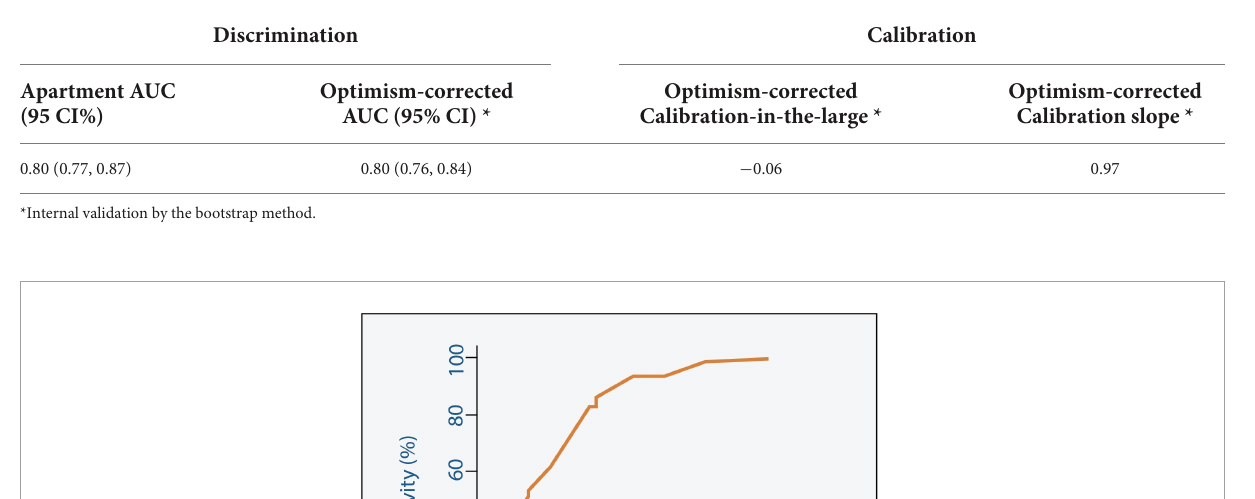
TABLE 6 Performance of the formulated predictors of 30-day outcome.